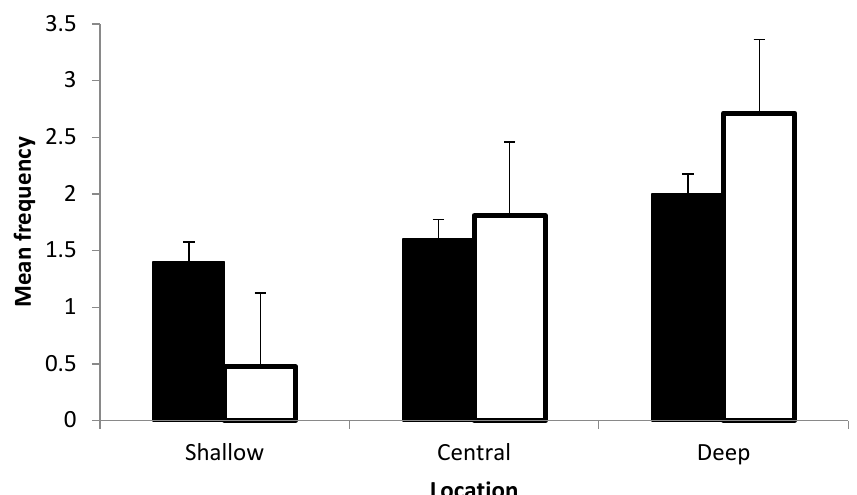
Figure 4. The mean frequency at which fish were found in each section of the aquaria at the 5 recorded observation times (minimum = 0, maximum = 5): black bars—with refugia; white bars—without refugia. Error bars represent standard error.